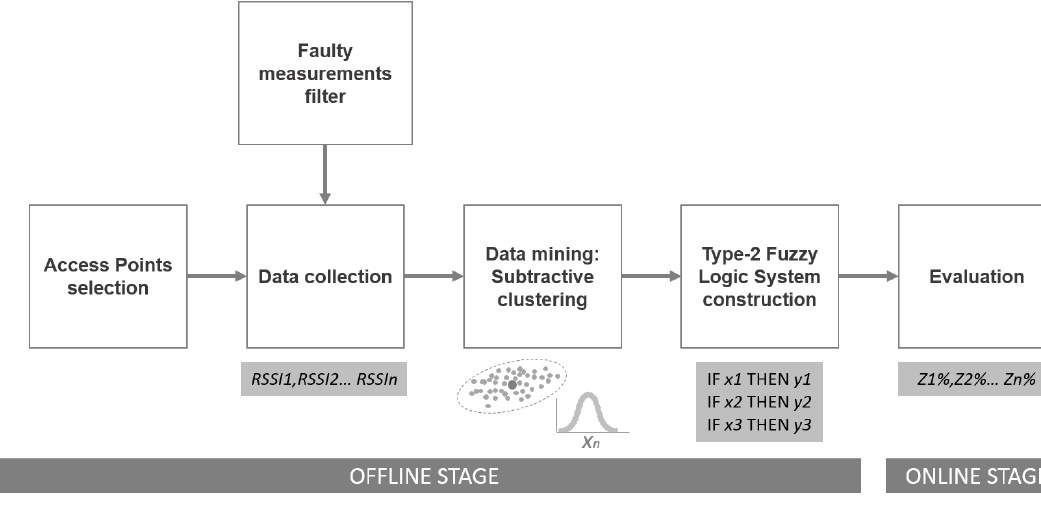
Figure 2. Block diagram of the proposed indoor location method (ILM).